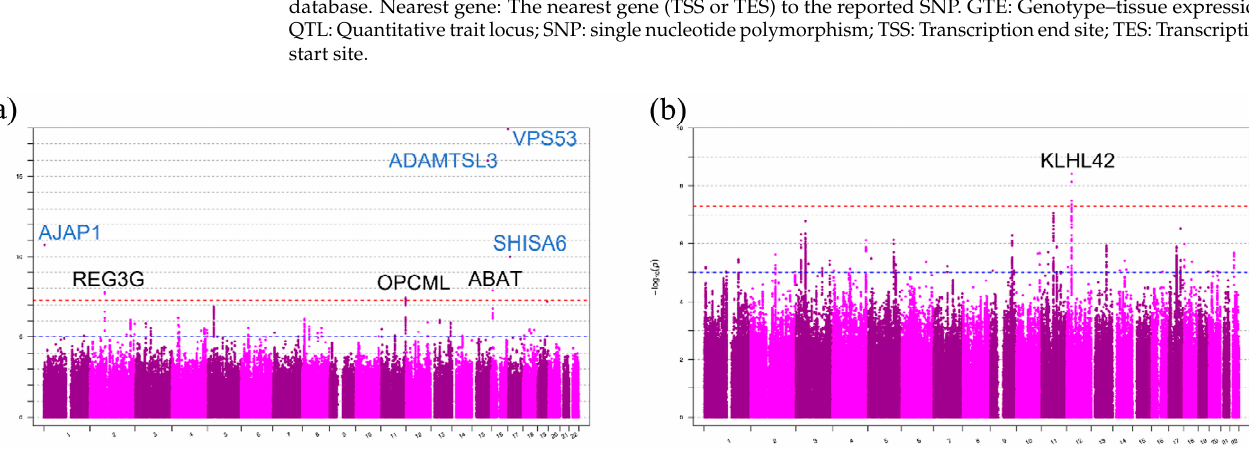
Figure 1. Manhattan plots of association of SNPs in Japanese patients with DDH and the UK Biobank data set. ( a ) Manhattan plot of the Japanese case and control studies with DDH. The gene in blue denotes the result from the direct genotyping of SNPs. ( b ) Manhattan plot of the UK Biobank case and control studies with DDH. The broken red line indicates a p -value < 5 × 10 − 8 . The broken blue line indicates a p -value < 1e-05. DDH, developmental dysplasia of the hip; SNP, single nucleotide polymorphism.